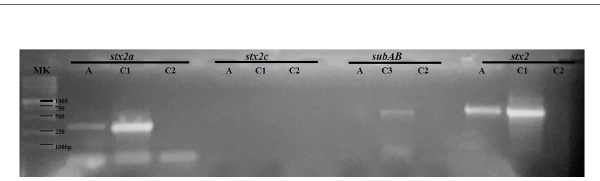
FIGURE 4 | Characterization of a STEC strain isolated from an endocervical sample by PCR assays. The STEC strain named 123/21 was subtyped for the stx2 gene. The amplicons were seeded on 1.5% agarose gel for 30 min at 80 Volts. A: STEC strain 123/21. C1: E. coli O157:H7 strain 125/99 (stx2a